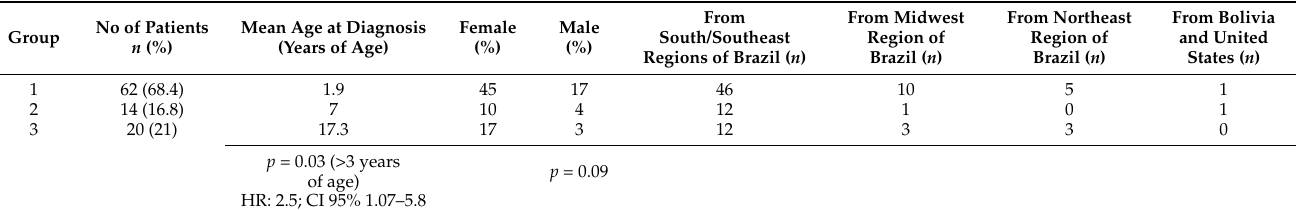
Table 1. Epidemiologic Features and their Relative Frequencies in Patients with PACT